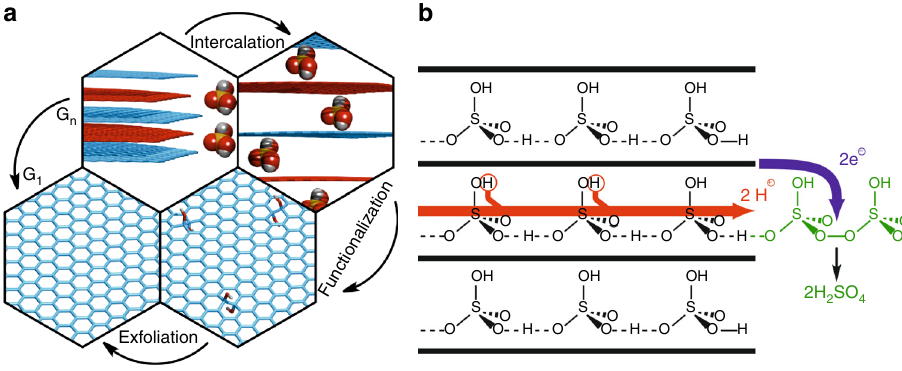
Fig. 1 Mechanism of graphene oxidation and exfoliation. a Schematic illustration of the chemical process of graphene formation. Interaction of graphite with sulfuric acid and an oxidizing agent leads to oxo-functionalized graphene after hydrolysis and enables delamination. Graphene is formed by reductive defunctionalization (G n : graphite, G 1 : graphene, index: number of layers). b Sketch of the proposed oxidation mechanism: electrons (blue) are transferred from conducting graphite sheets to the oxidizing agent, while charge balance is maintained by proton hopping through the hydrogen bond network of the sulfuric